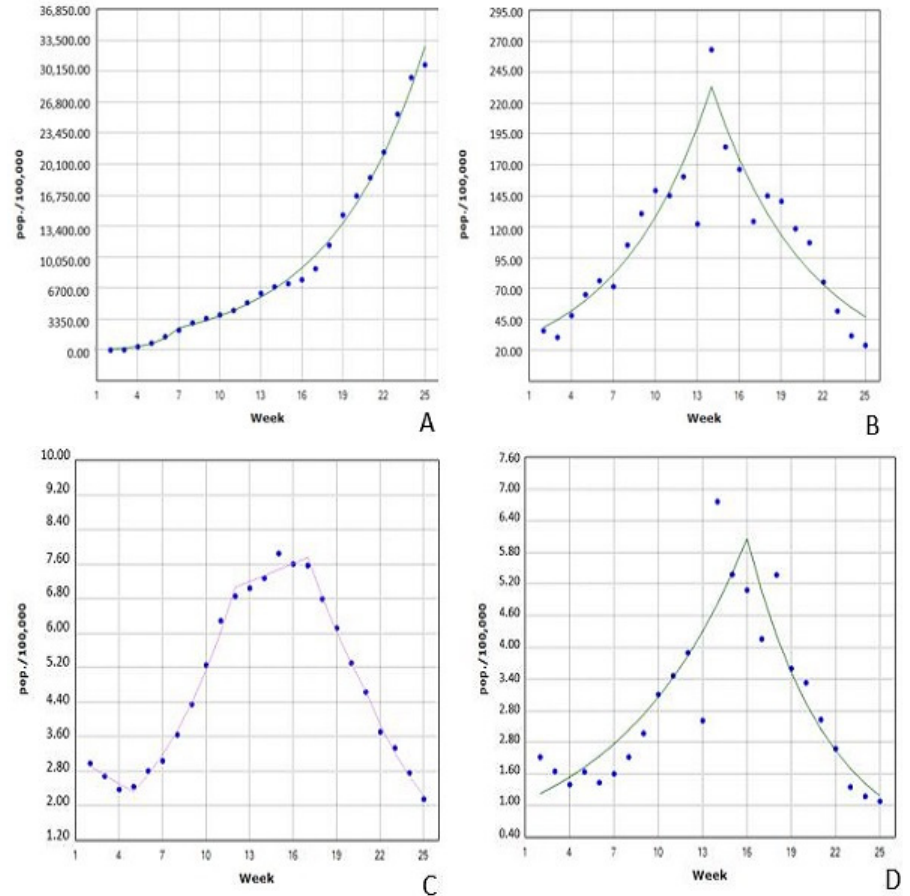
Figure 4. The course of vaccinations (per 100,000 population) ( A ), trends in the rate of SARS-CoV-2 cases ( B ), COVID-19-related ICU admissions ( C ) and COVID-19-related deaths ( D ) during the study period.